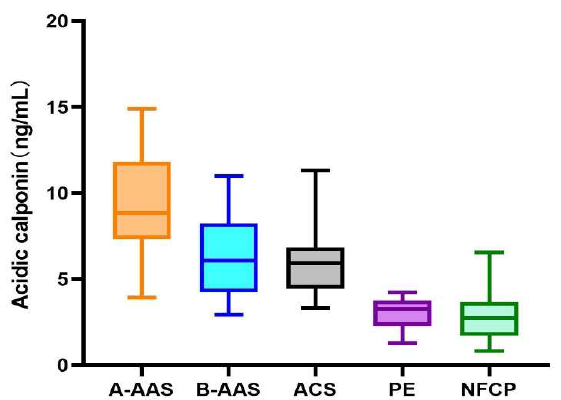
Figure 4. Acidic calponin levels in patients examined in the present study according to final diag- nosis.